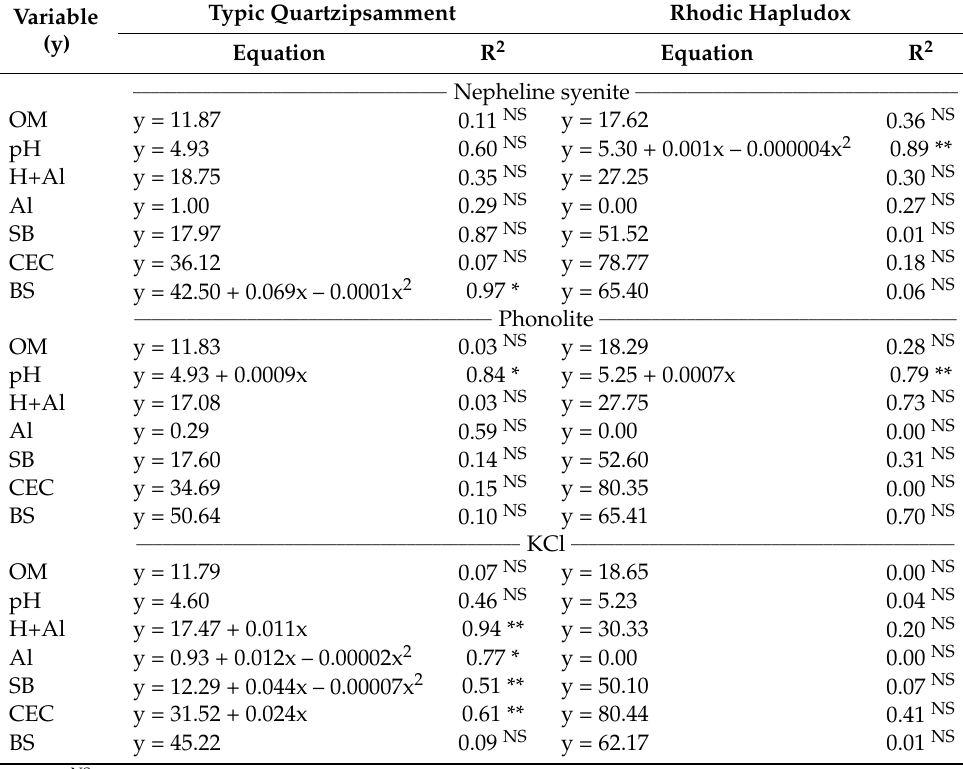
Table 5. Determination coefficients (R 2 ) and regression equations that best fit the relationships between the chemical attributes of soils after maize cultivation as a function of potassium sources.